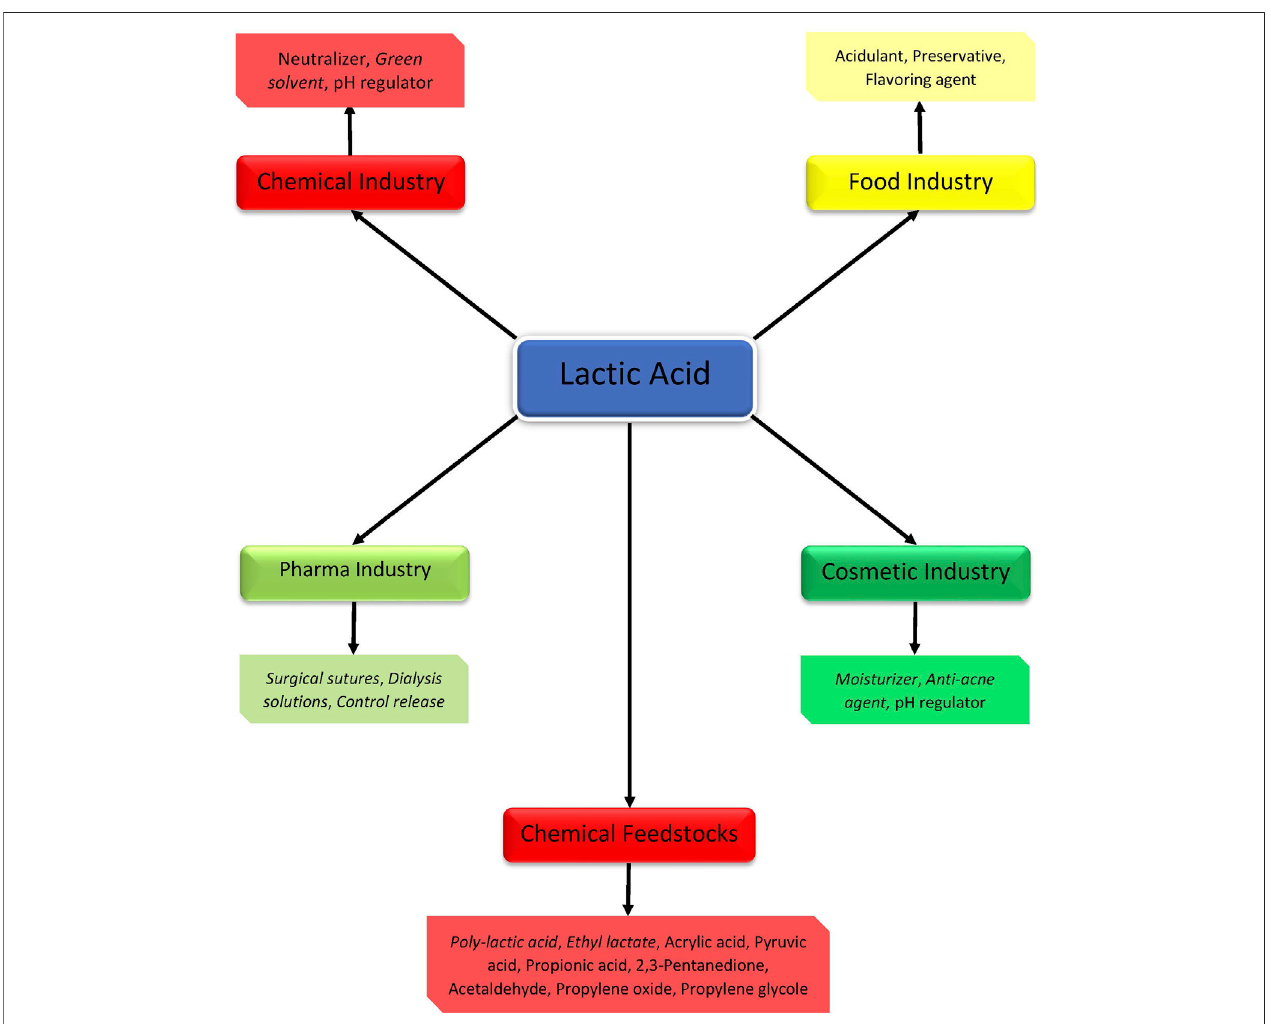
FIGURE 1 | Applications of lactic acid in different industries (Newer application are given in italic).